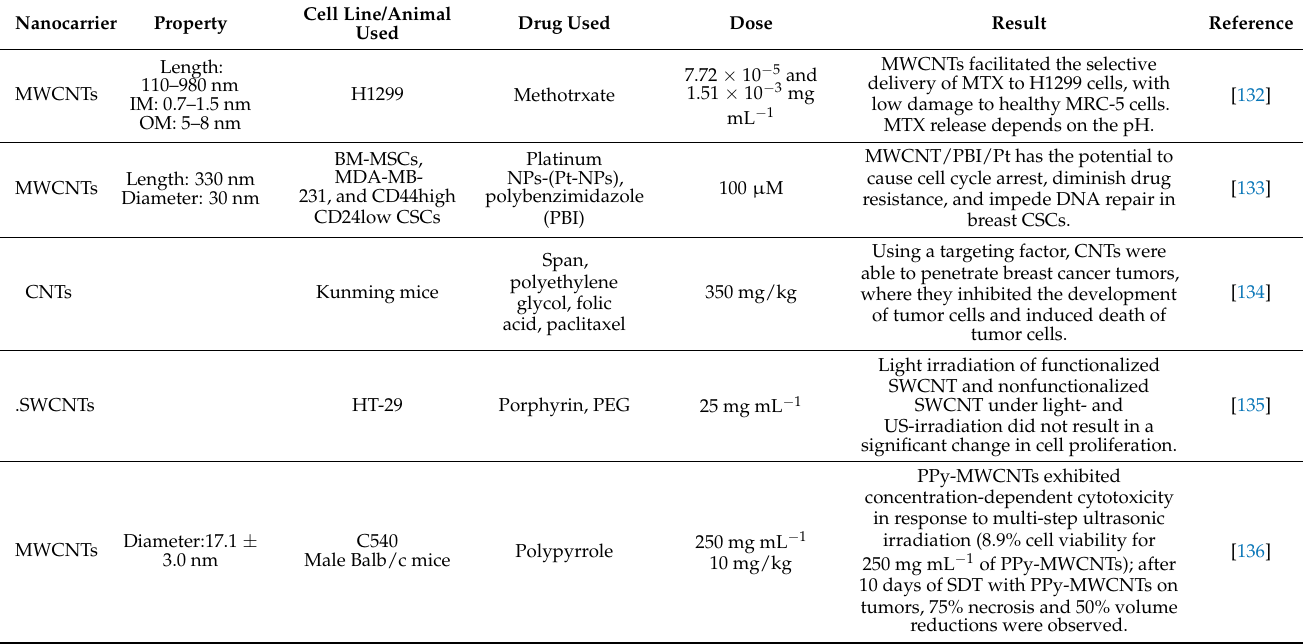
Table A1. Different carbon based nanocarriers and their application in cancer